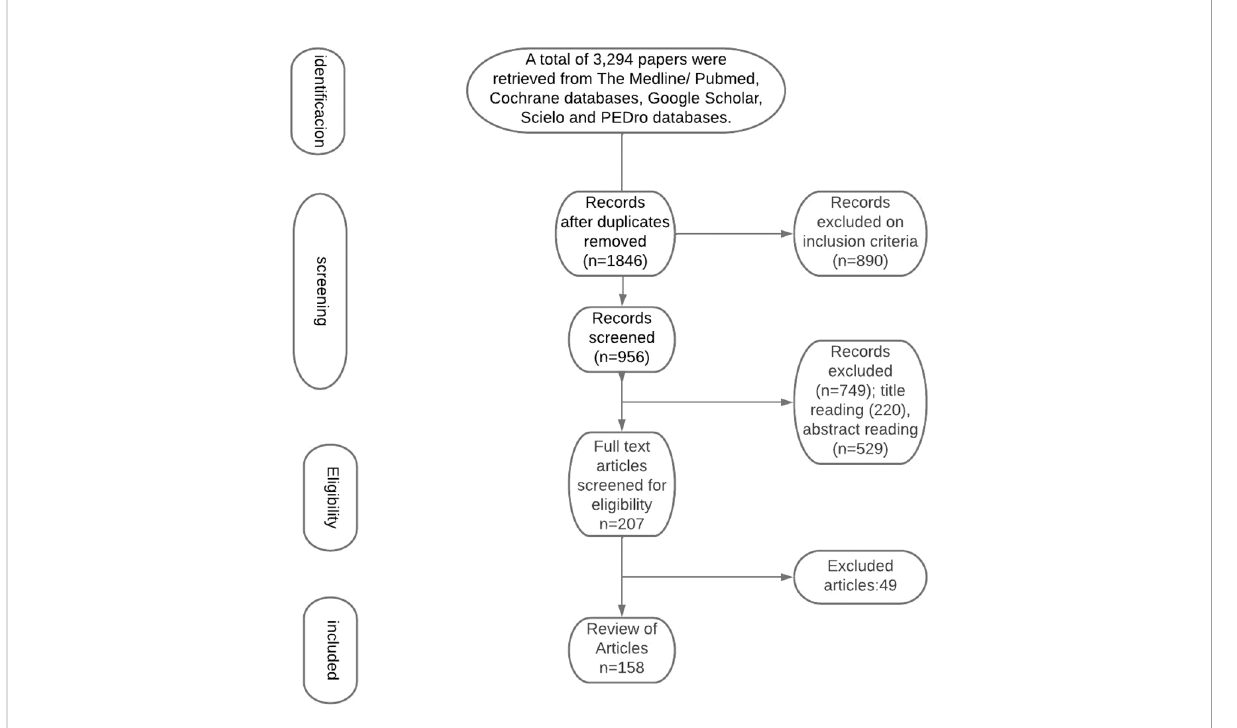
FIGURE 1 Flow Diagram represents our process of article